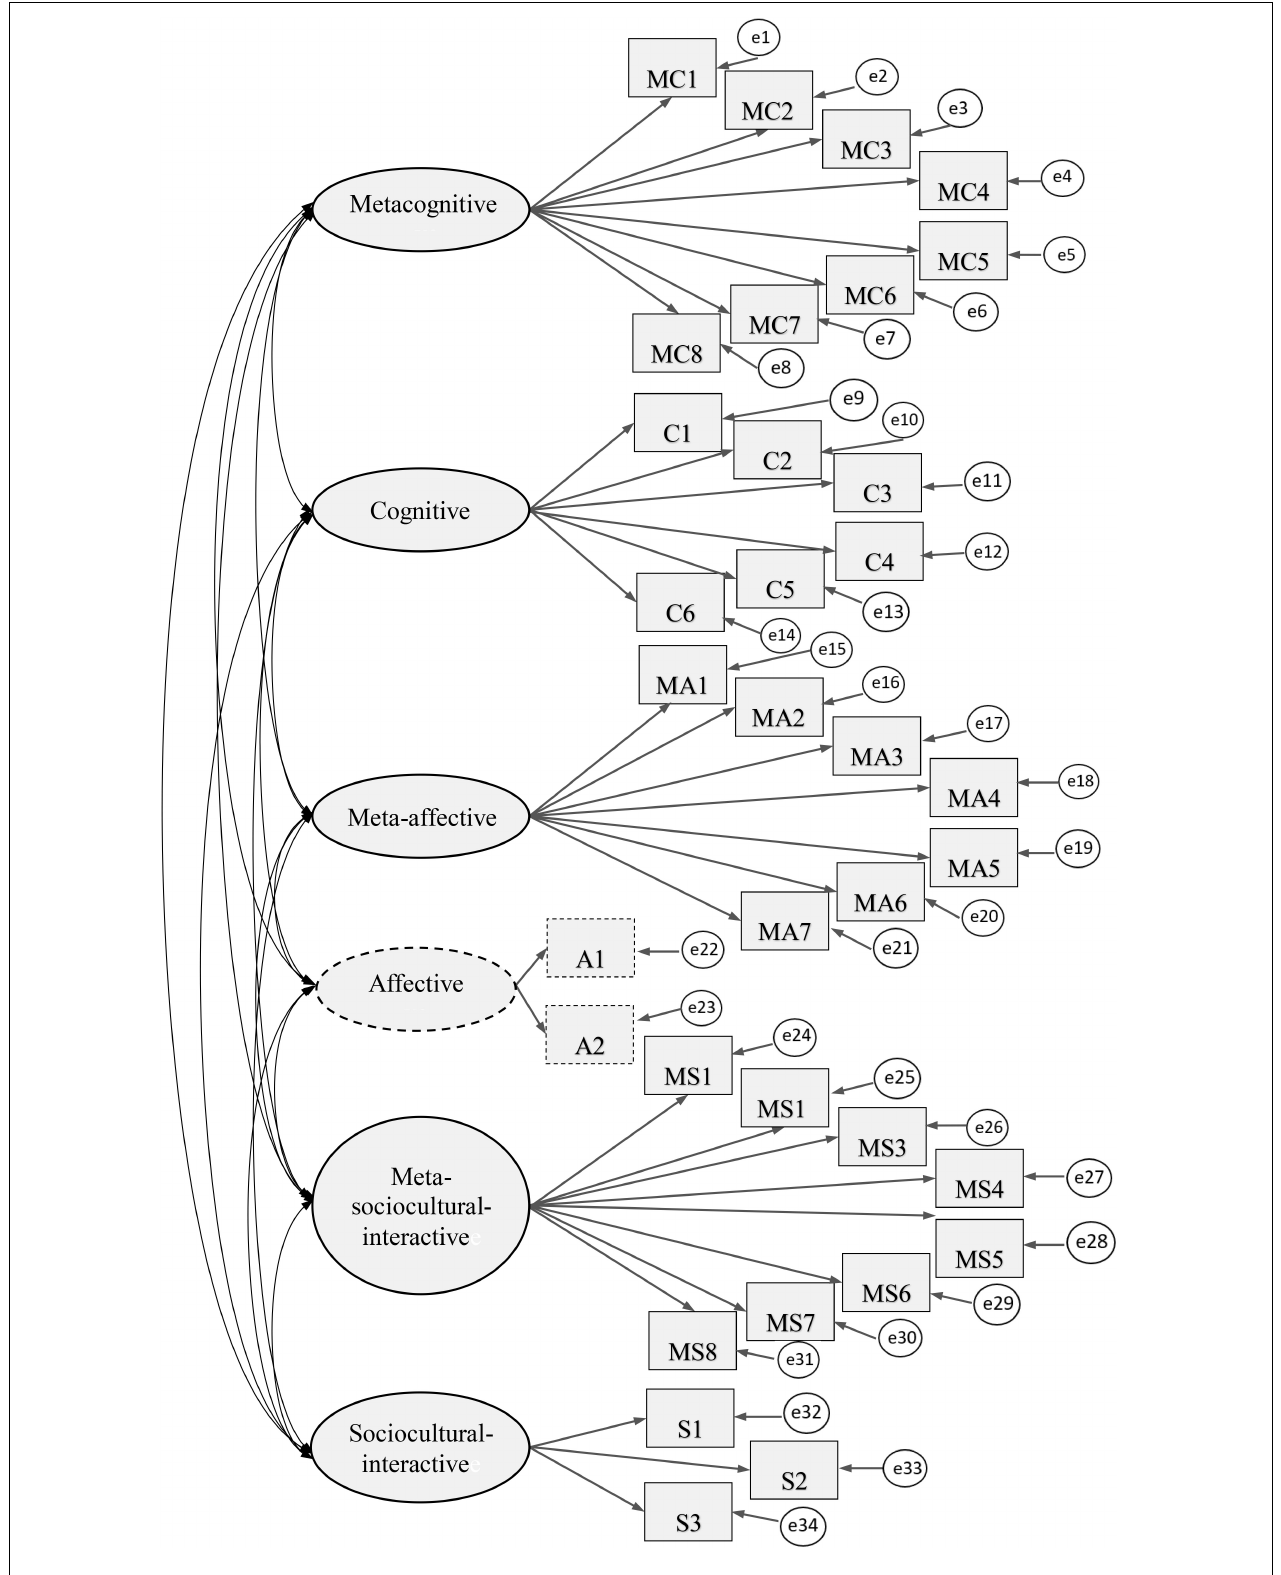
FIGURE 1 | The six-factor structural model of the SRFLLSQ, displaying latent and observed variables and measurement errors ( N = 2223).